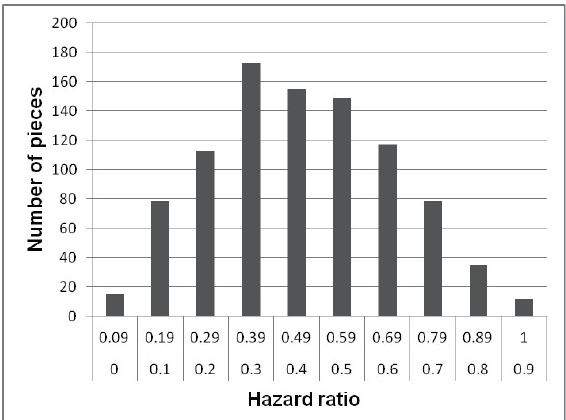
Figure 10. Histogram of the level of hazard of the detected